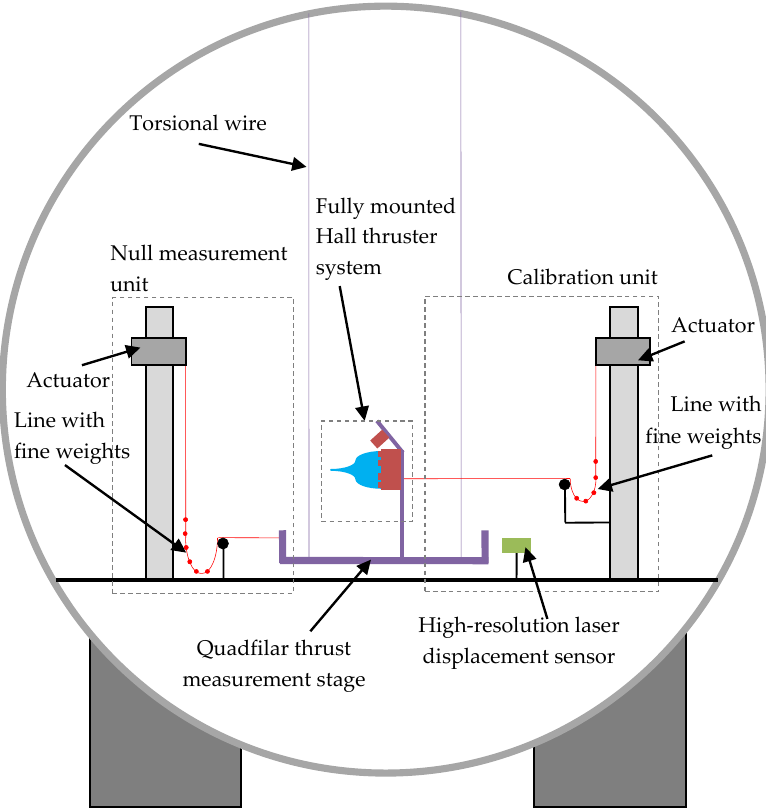
Figure 3. Schematic of the quadfilar measurement system installed in the Space Environment Simulation Chamber.